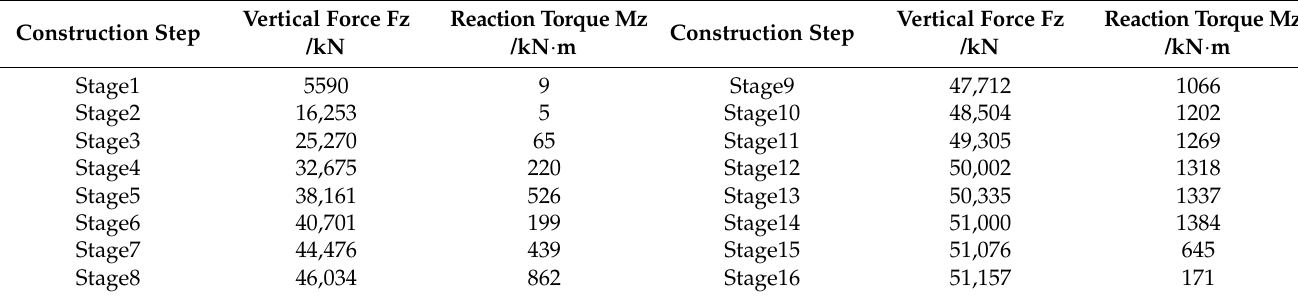
Table 3. Reaction force of the tower bottom at each construction